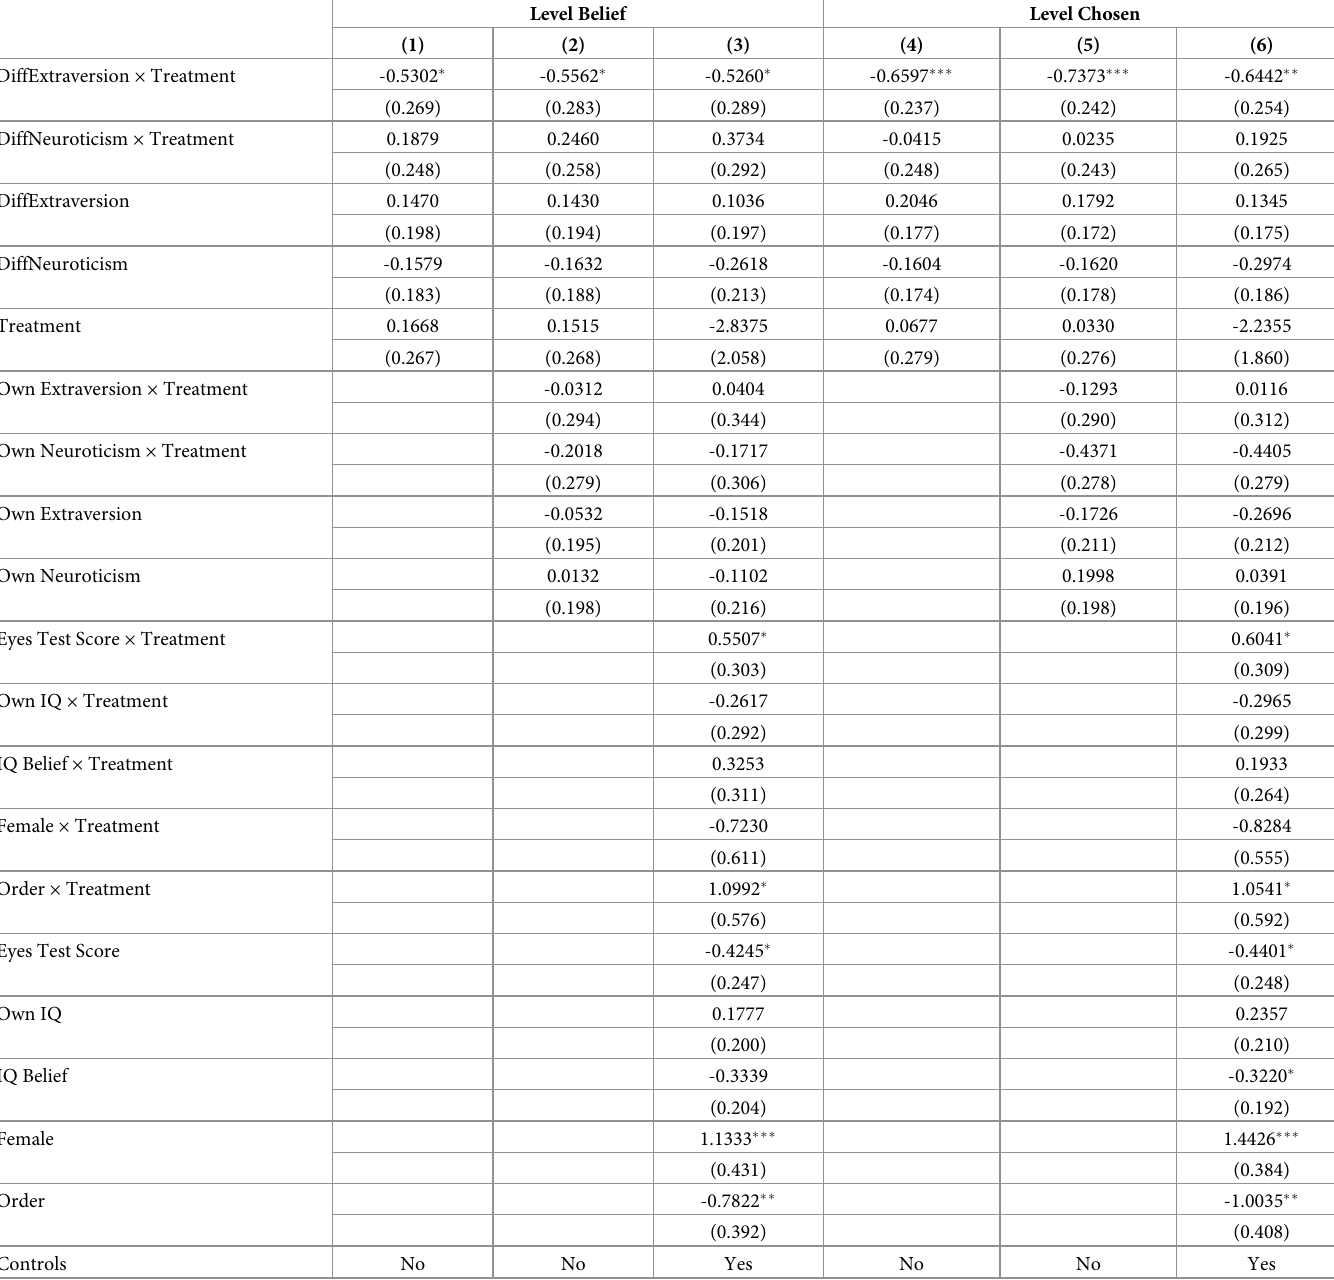
Table 2. Impact of (absolute) difference between own personality and beliefs about partner’s personality on level-k strategy